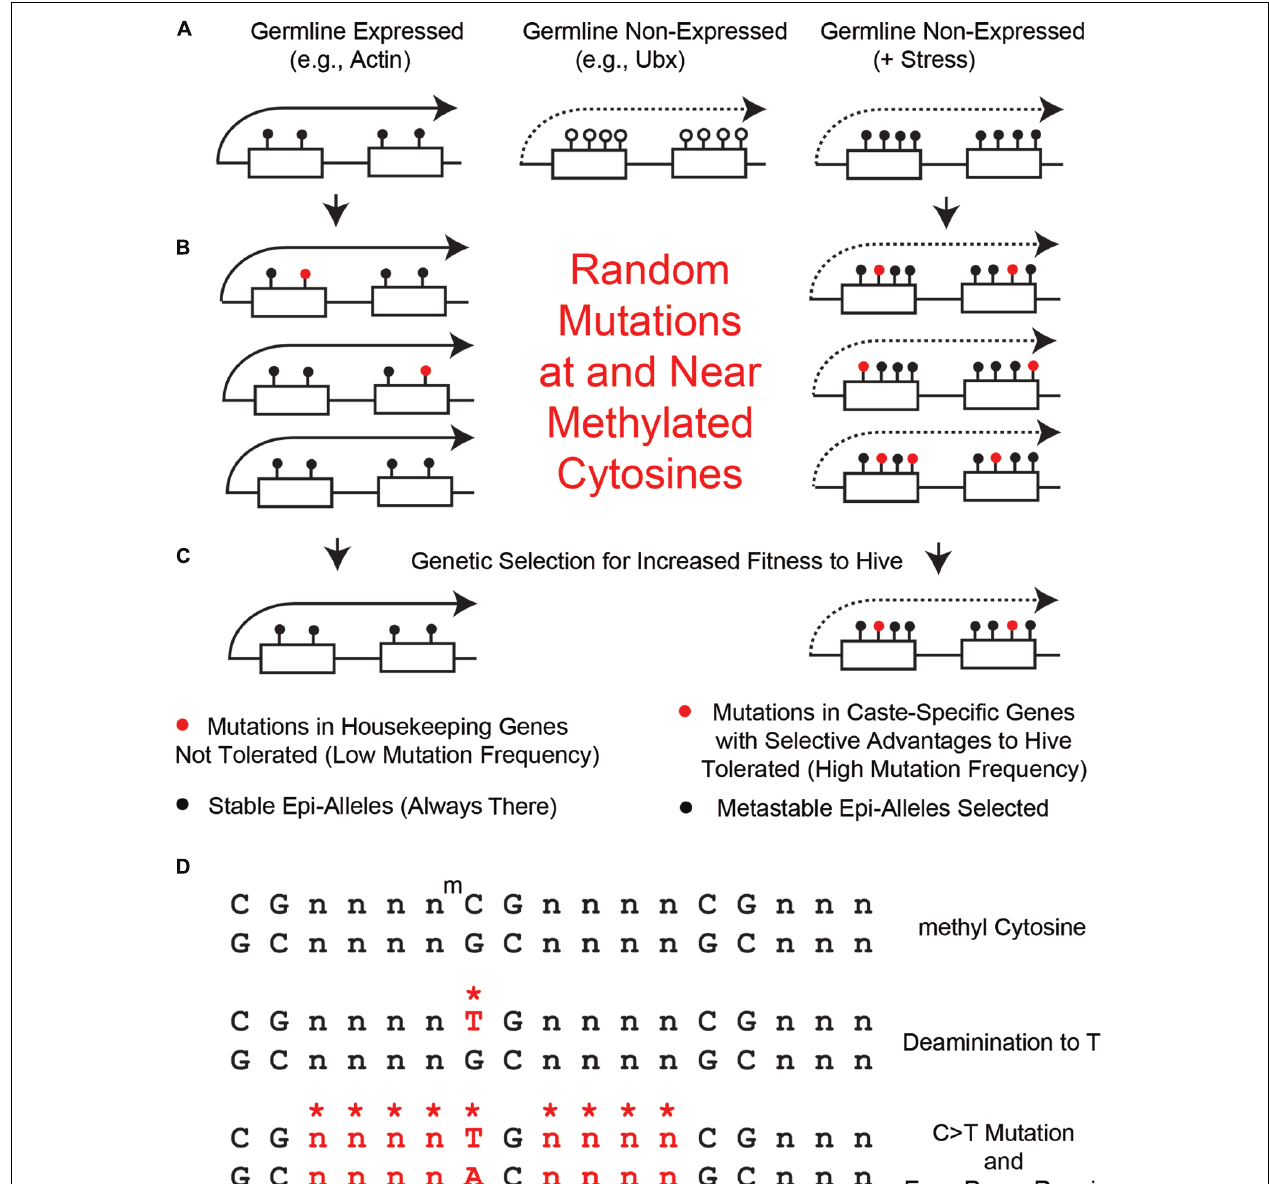
FIGURE 4 | Random mutations generated at and near methylated cytosines. (A) Left, in germline high-expressed genes, such as actin, there are few CGs and high levels of 5mCs (black circles). Middle, in germline non-expressed genes, such as Ubx, there are many CGs and low levels of 5mCs (open circles). Right, in non-expressed genes in the presence of stress ( + Stress), we propose that many of the CG s become methylated by Trx-switching-to-PCG, described in Figure 2A . (B) Left, few 5mCs in the